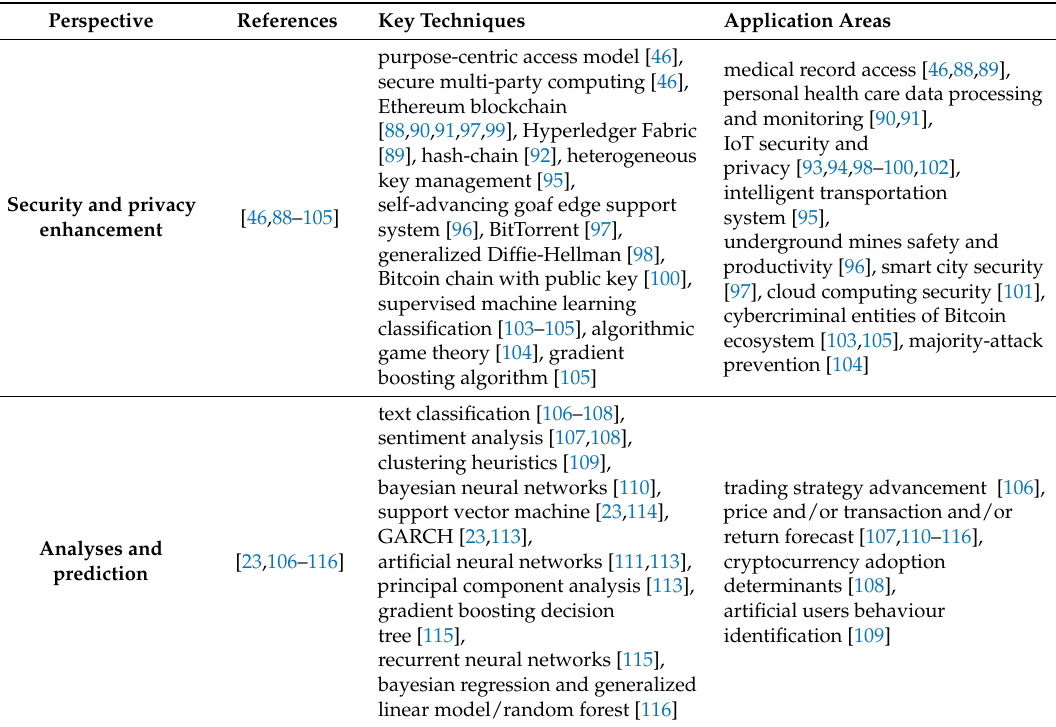
Table 1. Summary table of Big Data and cryptocurrency related applications since